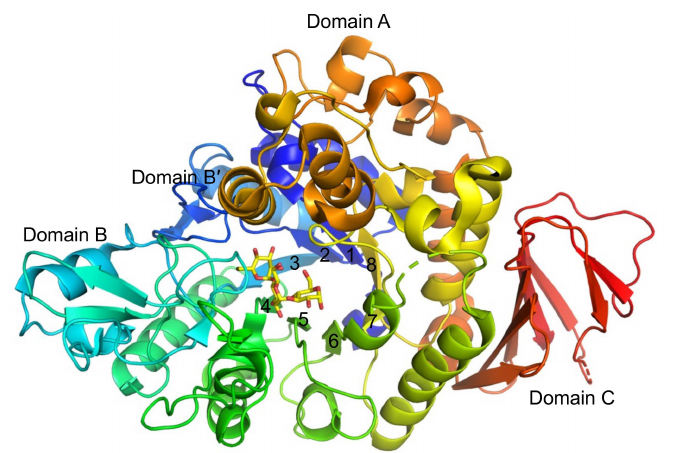
Figure 1. Overall structure of BspAG13_31A. The structure of the BspAG13_31A E256Q mutant in complex with G3 (PDB entry, 5ZCD) is shown in rainbow coloring from the N-terminus (blue) to C-terminus (red). Yellow sticks represent G3 bound to subsites − 1 to +2. Numbers indicate the numbering of the β -strands, forming domain